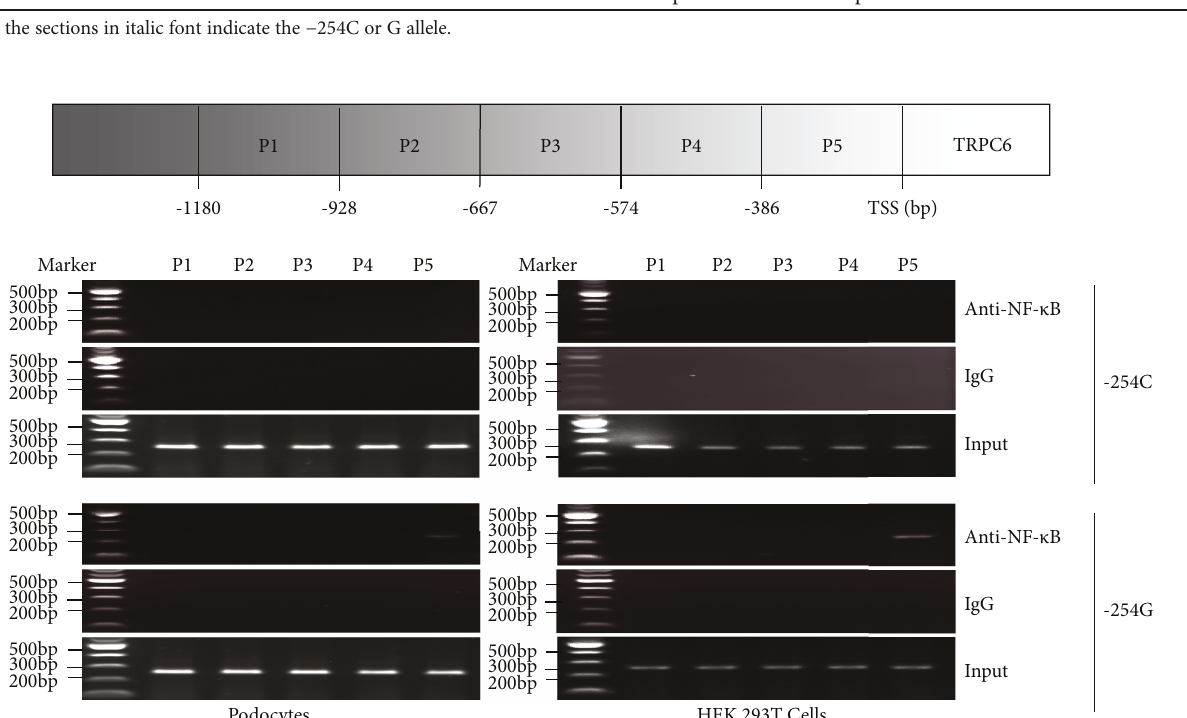
Note: the sections in italic font indicate the − 254C or G allele.